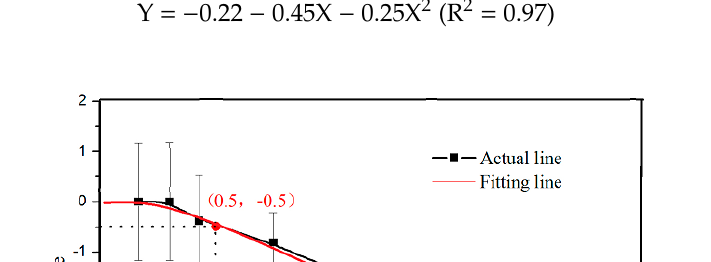
Figure 2. The behavior curve of limonene.